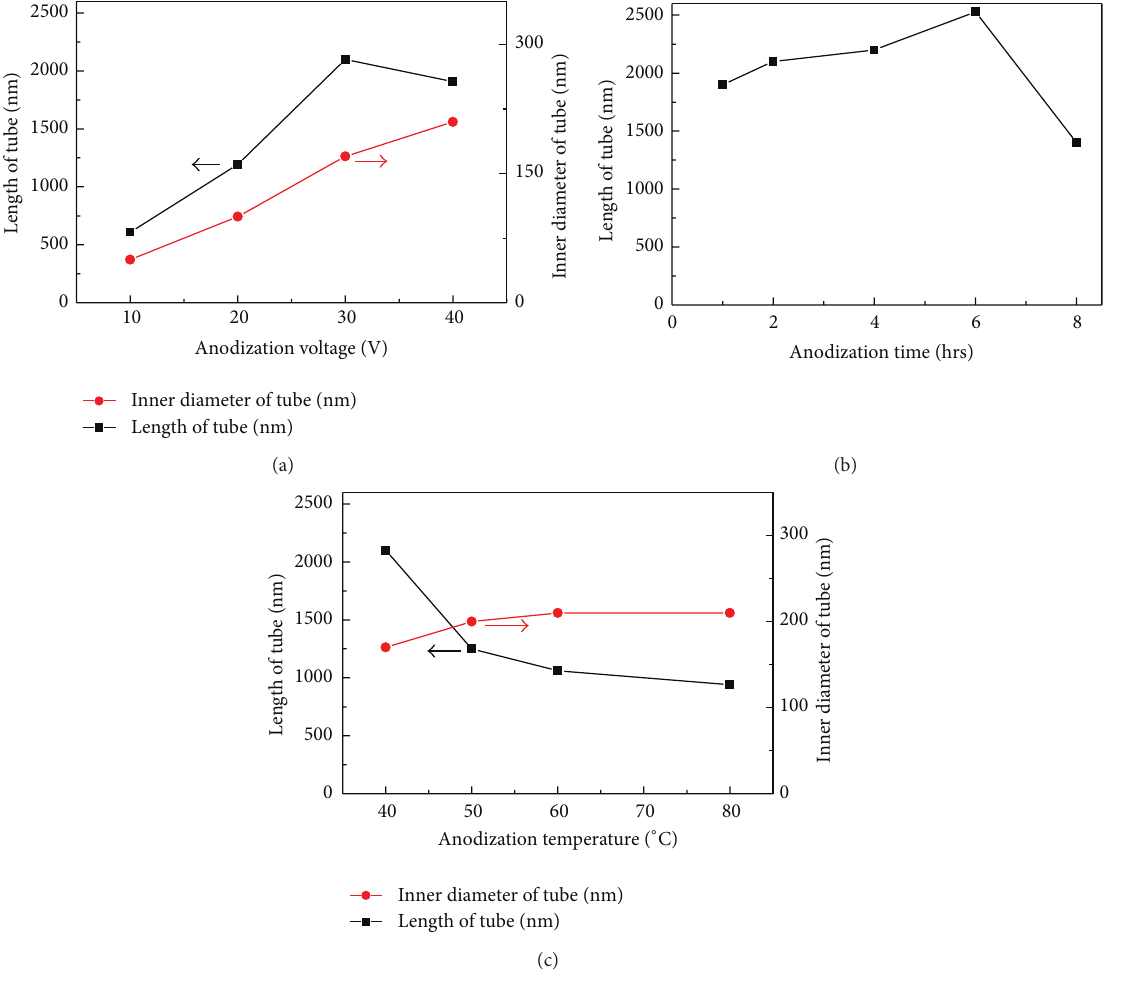
Figure 4: Dimensional control of titanium dioxide nanotube arrays with different preparation parameters of (a) anodization voltage, (b) electrocatalysis times, and (c) bath